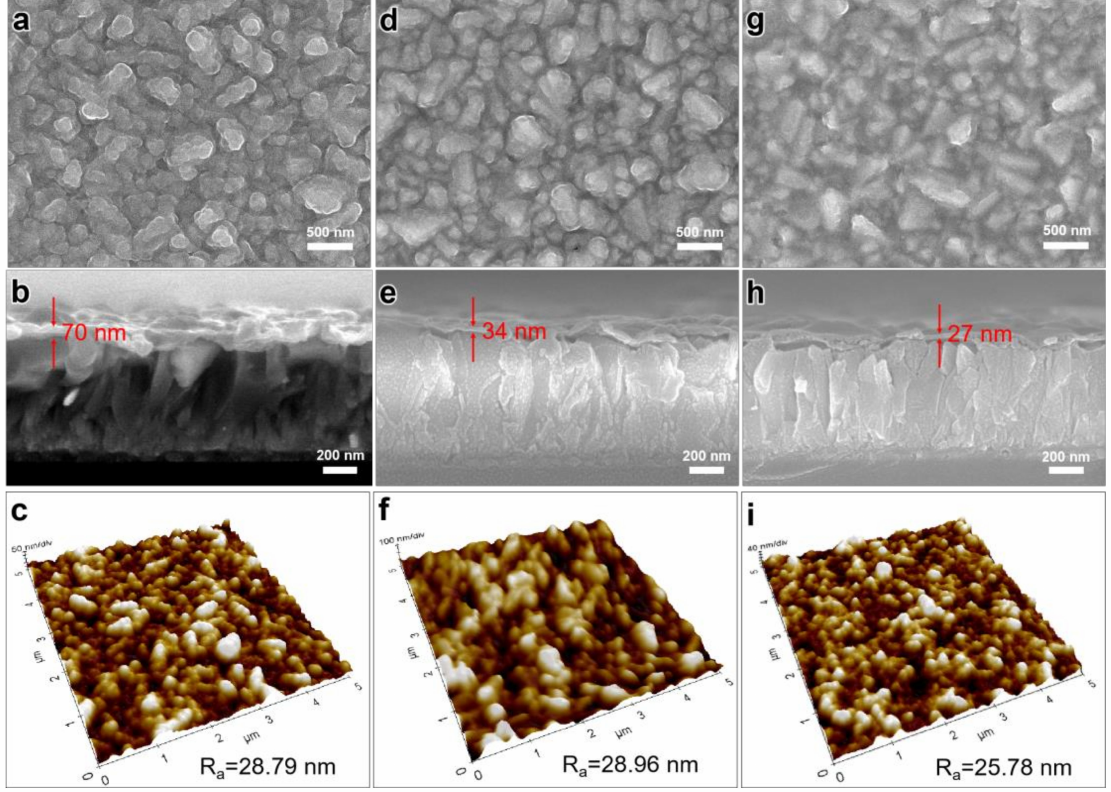
Figure 2. Top-view, cross-sectional SEM and AFM images of ( a – c ) CN/FTO-520, ( d – f ) CN/FTO-550, and ( g – i )